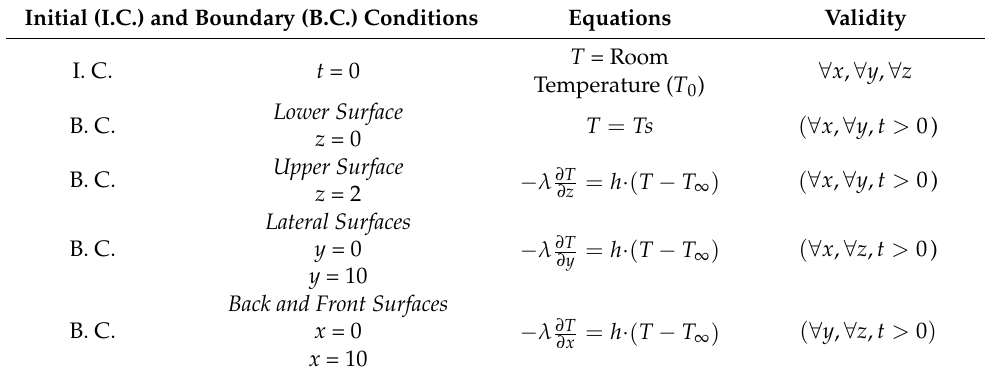
Table 1. Initial and boundary conditions for solving the thermal energy equation.